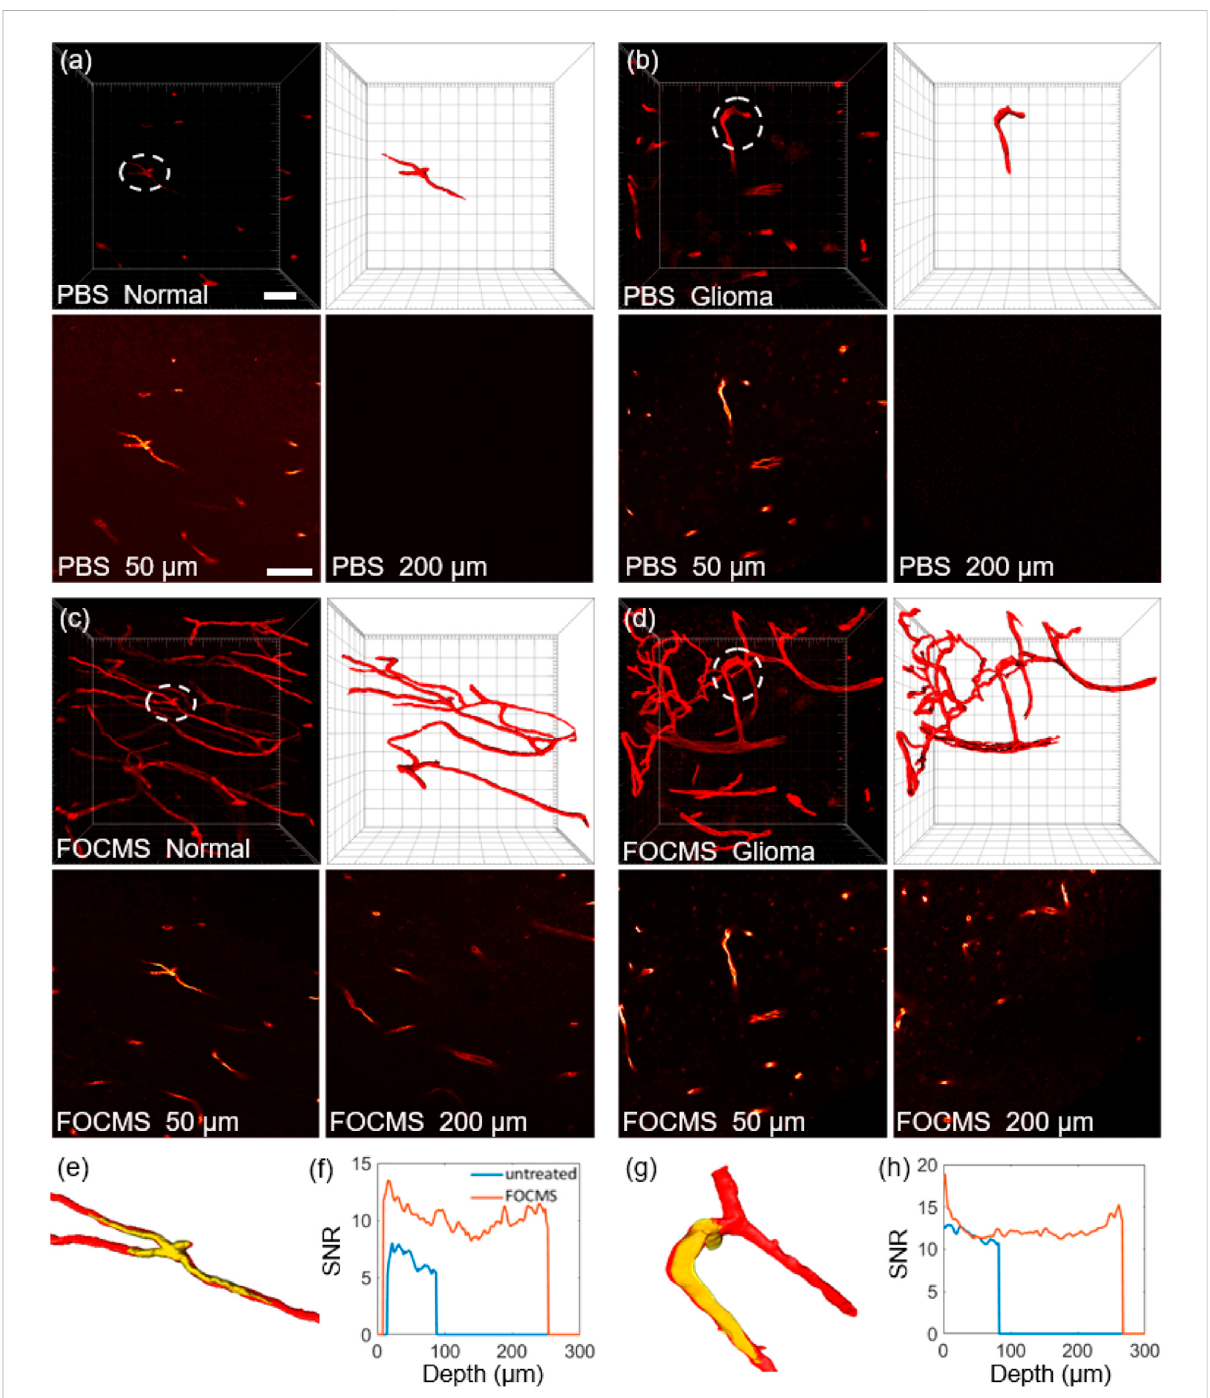
FIGURE 5 Application of FOCMS in human brain tissue imaging. Comparison of three-dimensional imaging of (A) normal human brain tissue and (B) glioma without optical clearing. Top left: the original imaging, top right: detailed structure of blood vessel morphology, bottom: selected single imaging at the depth of 50 μ m (left) and 200 μ m (right) in (A) and (B) , respectively. After using FOCMS, three-dimensional imaging of (C) normal humanbraintissueand (D) glioma,respectively.Topleft:theoriginalimaging,topright:detailedstructureofbloodvesselmorphology,bottom: selected single imaging at the depth of 50 μ m (left) and 200 μ m (right) in (C) and (D) , respectively. Comparison of (E) morphology changes and (F) SNR of normal brain tissue before and after FOCMS. (G) Morphology changes and (H) SNR for glioma with and without optical clearing. Scale bar: 50 μ